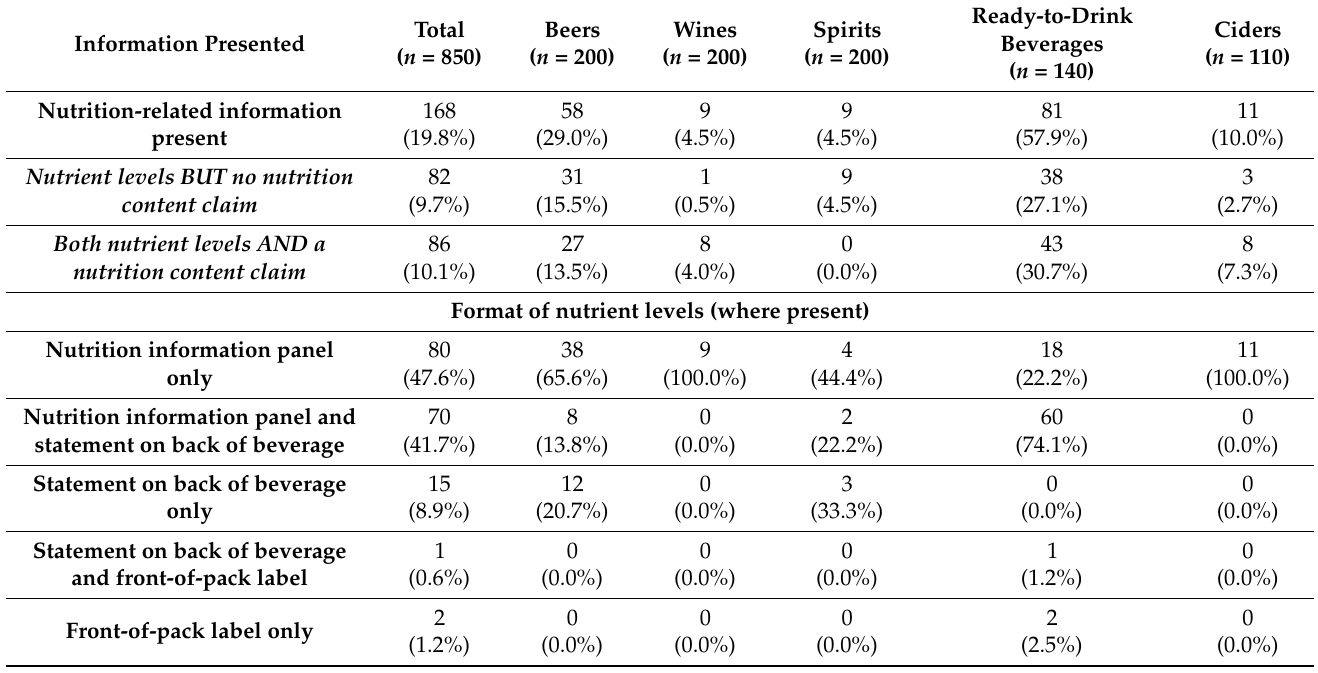
Table 2. Frequency and prevalence nutrition-related information presented on alcoholic